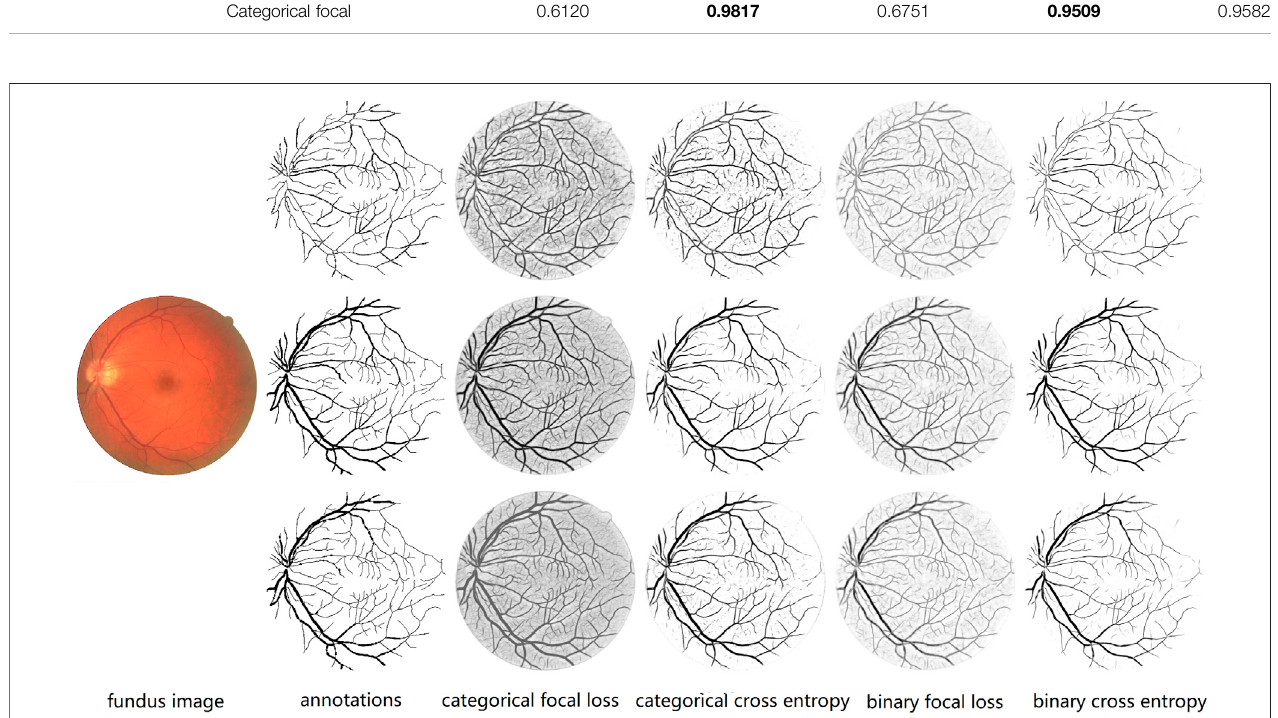
FIGURE11 | Comparison of different loss functions. Fromthe left toright: fundus retina image, annotationsofthin, original and thick vessels, prediction probability maps ofthin, original,and thick vessels through categorical focal loss,categoricalcross entropy, binary focalloss,and binarycross entropy, respectively.We cannotice that categorical cross entropy is the best one for our proposed method because it can help us segment blood vessels more clearly, especially thin blood vessels.